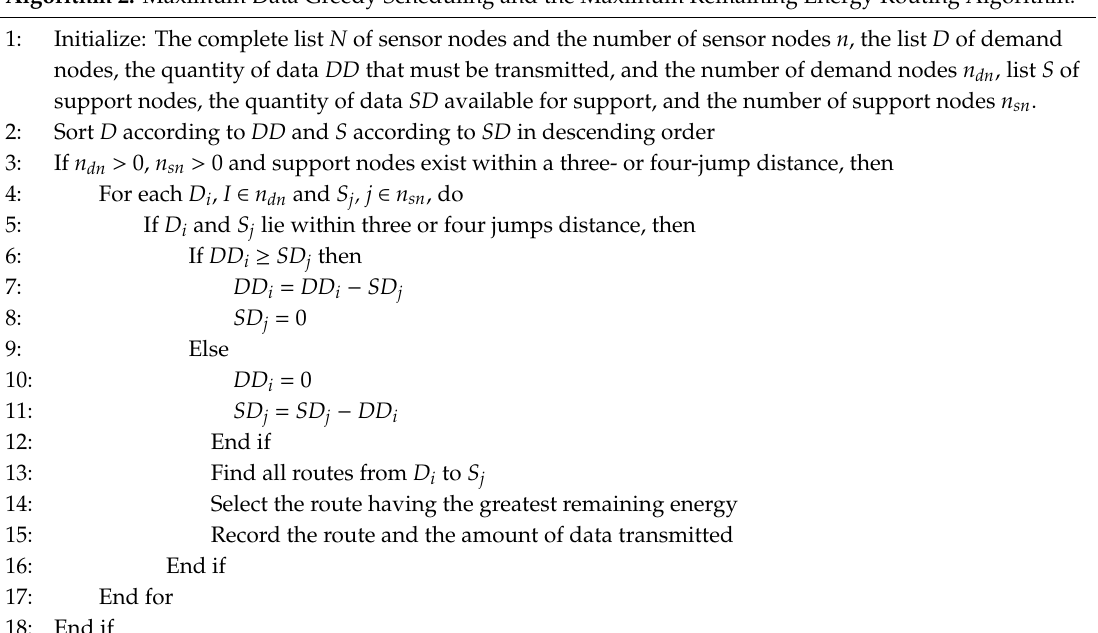
Algorithm 2. Maximum Data Greedy Scheduling and the Maximum Remaining Energy Routing